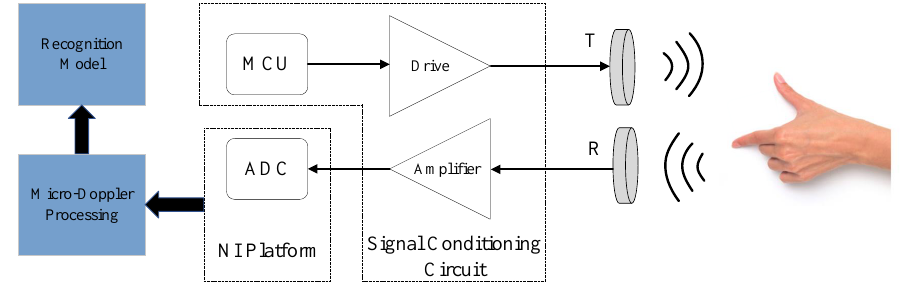
Figure 2. The block diagram of the proposed